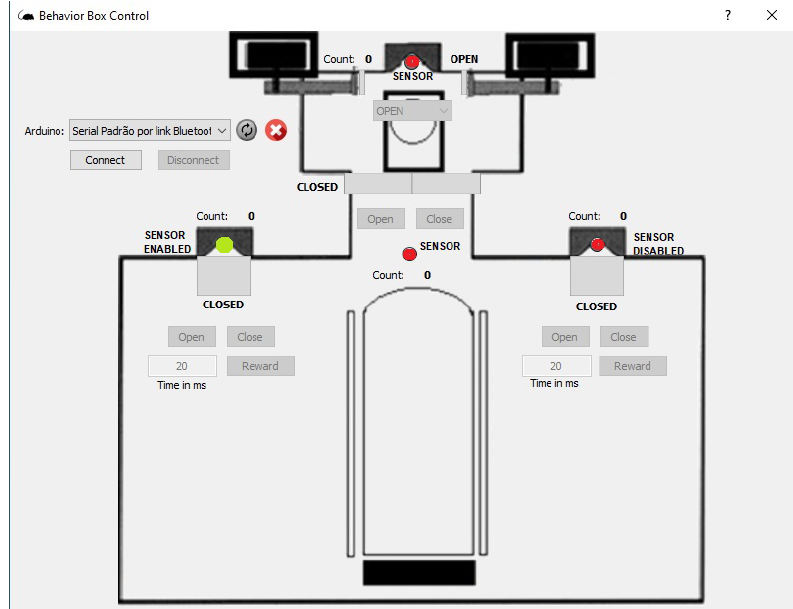
Figure 5. Behavioral box control software interface.